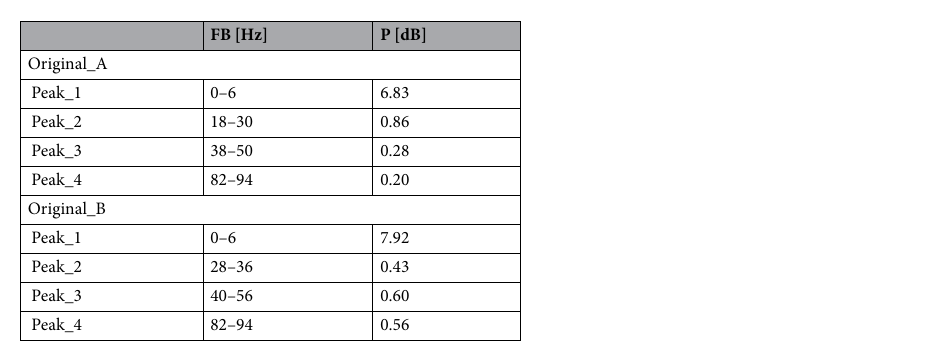
around each of the identified principal frequency component of the PS, corresponding to the local maxima of the spectrum. In detail, each FB was calculated as the full width at half-maximum amplitude of each peak. According to our analysis, for each waveform, four principal components (Peaks) were identified (red triangles in Fig. 1B). Data on FB values and power signal (P) for each of the four peaks (Peaks 1–4) identified from the PS of Original_A and Original_B are reported in Table 1. For both waveforms (i.e., Original_A and Original_B) three different Peaks were selected to cover the full frequency range, namely: i) the low-frequency peak (Peak_1A and Peak1B), ii) the medium-frequency peak with higher power signal (Peak_2A and Peak_3B for Original_A and Original_B, respectively), and iii) the high-frequency peak (Peak_4A and Peak4B), and corresponding time-domain curves were reconstructed through inverse FFT (Fig. 2). In this way, starting from the Original shear stress profiles, we obtained a set of test-curves modulating SA and SR, respectively. Moreover, a time-constant (SR = 0) and low-stress amplitude (1 dyne/cm 2 ) waveform was included in the data set and used as a negative control (NC); the temporal duration of the NC was set to 0.5 s to match that of the dynamic test waveforms. In Table 2, we reported SA and SR values for each of the test-curves of our data set. As the considered curves discrete signals, their SA and SR values were calculated according to (eqs 1 and 2):